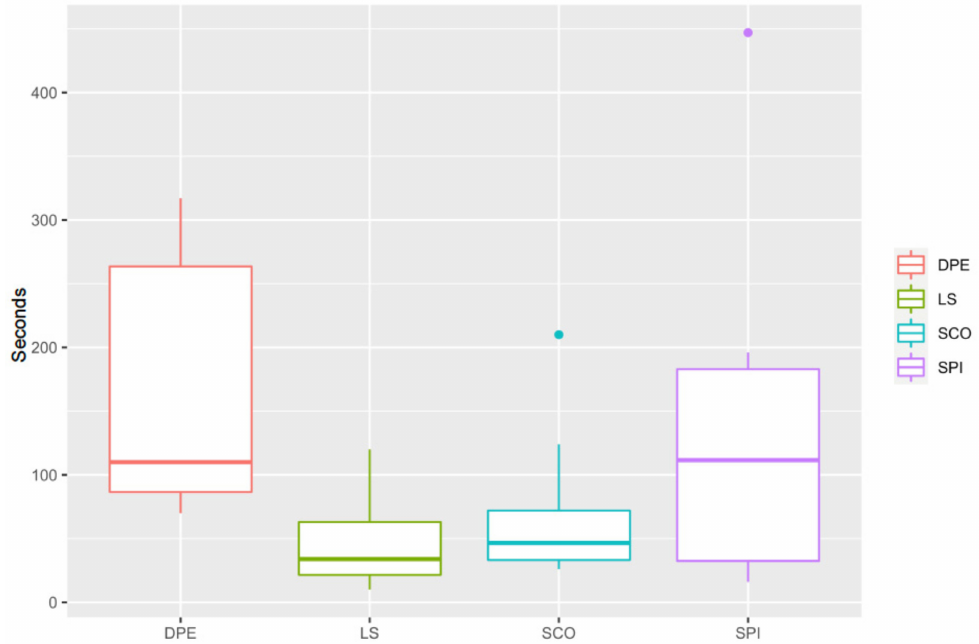
Figure 2. Time to perform the technique (not counting with the time for drugs administration) in seconds. DPE, dural puncture epidural injection; LS, epidural injection in the lumbosacral space; SCO, epidural injection in the sacrococcygeal space; SPI, injection in the subarachnoid space. No difference was found between the